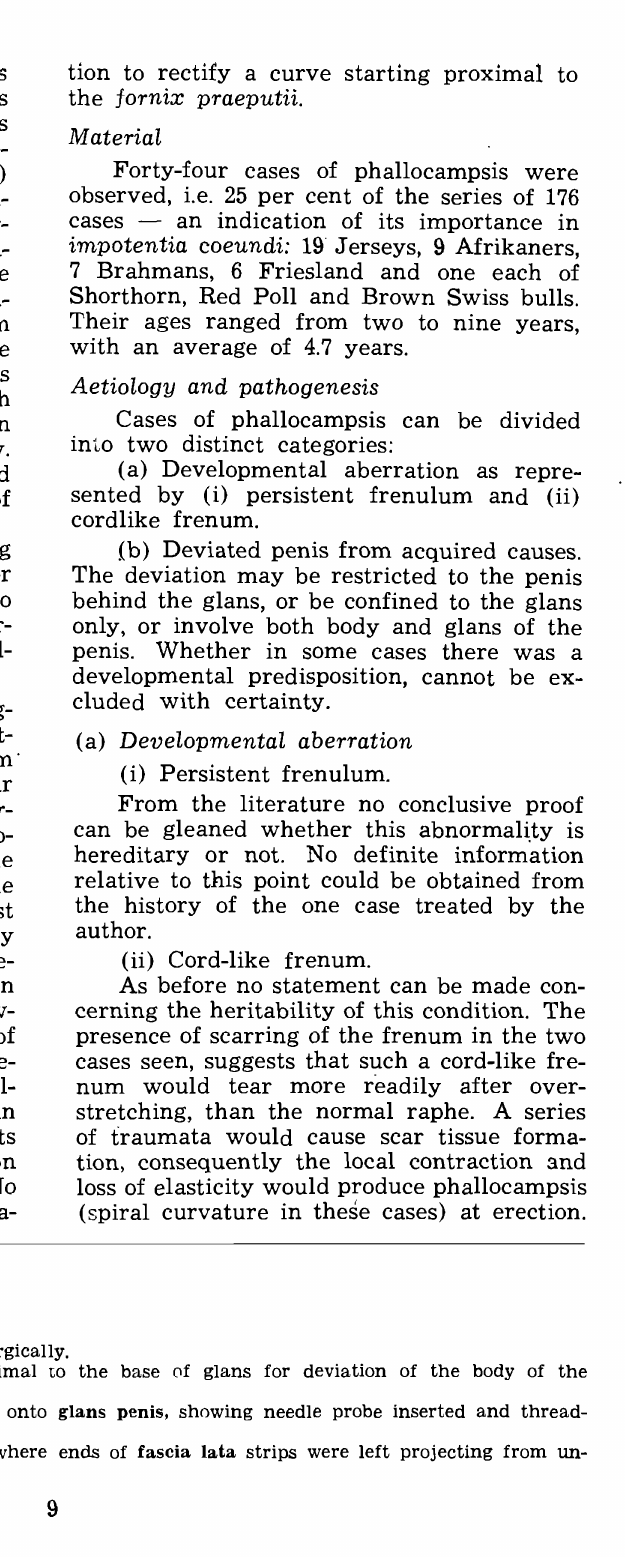
Fig. 1. Fibropapillomata of galea glandis. Fig. 2, Jersey - semispiral glans penis. Fig. 3, Removal of